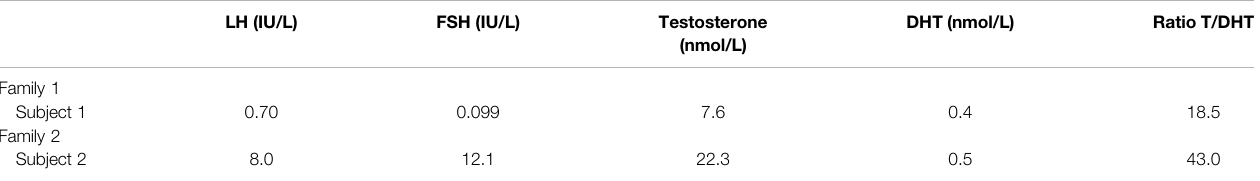
TABLE 2 | Biochemical characteristics of affected subjects.